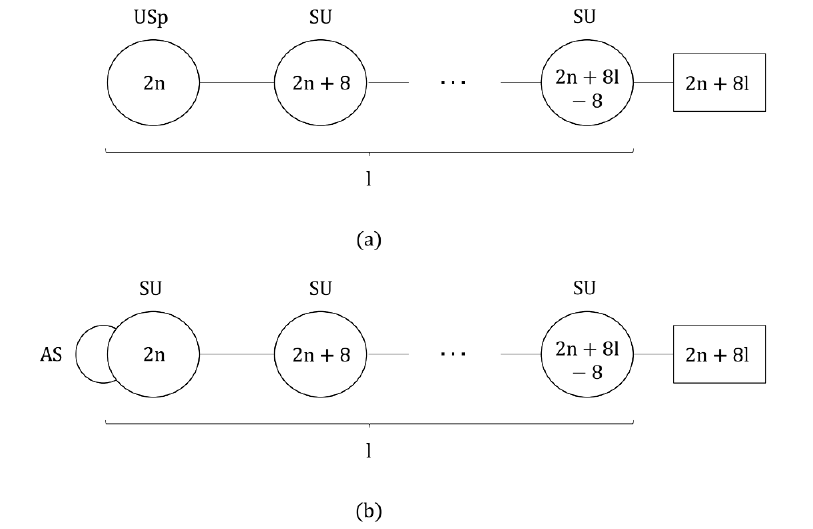
Figure 3 . Quivers of 6 d gauge theories which are the low-energy tensor branch descriptions of certain 6 d